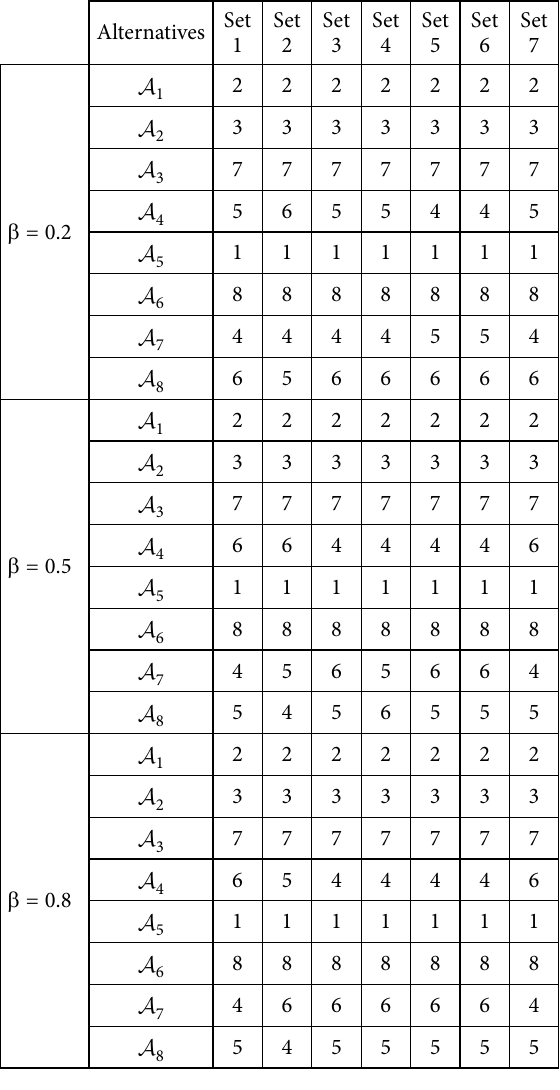
Table 8. Ranking of the alternatives in the sensitivity analysis